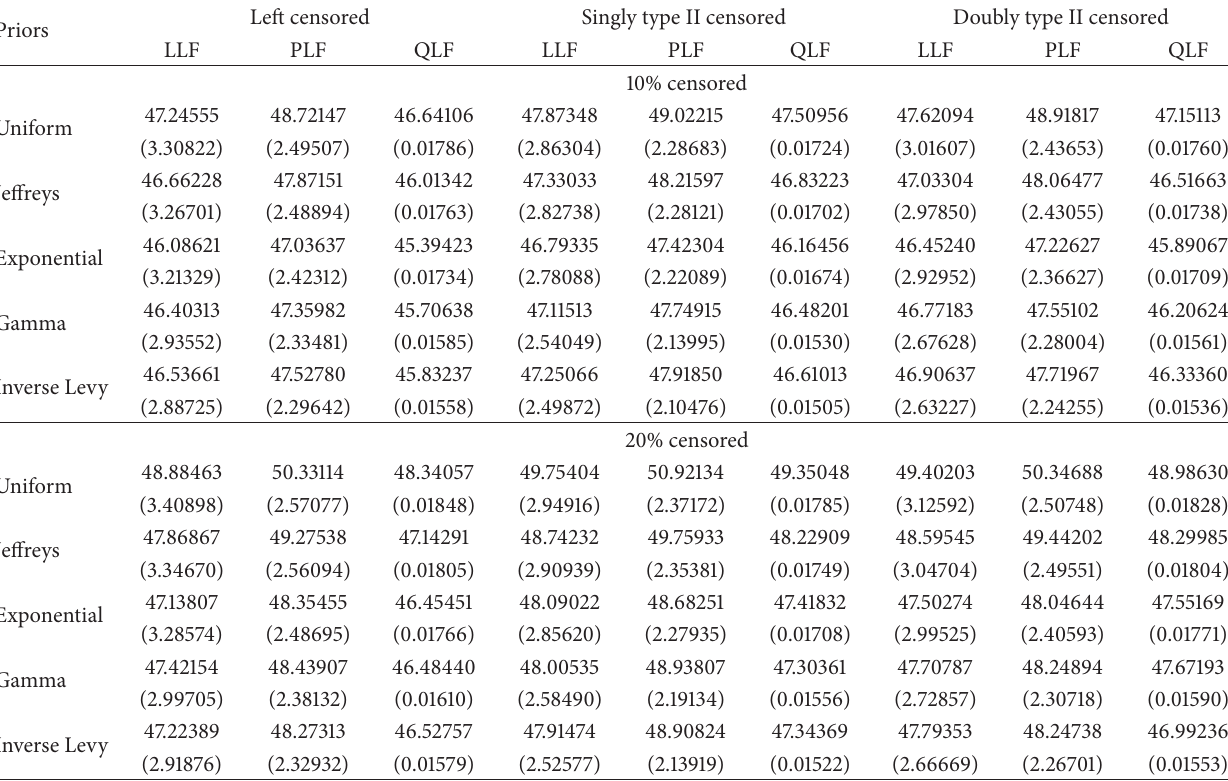
Table 8: Bayes estimates and posterior risks under real life data.